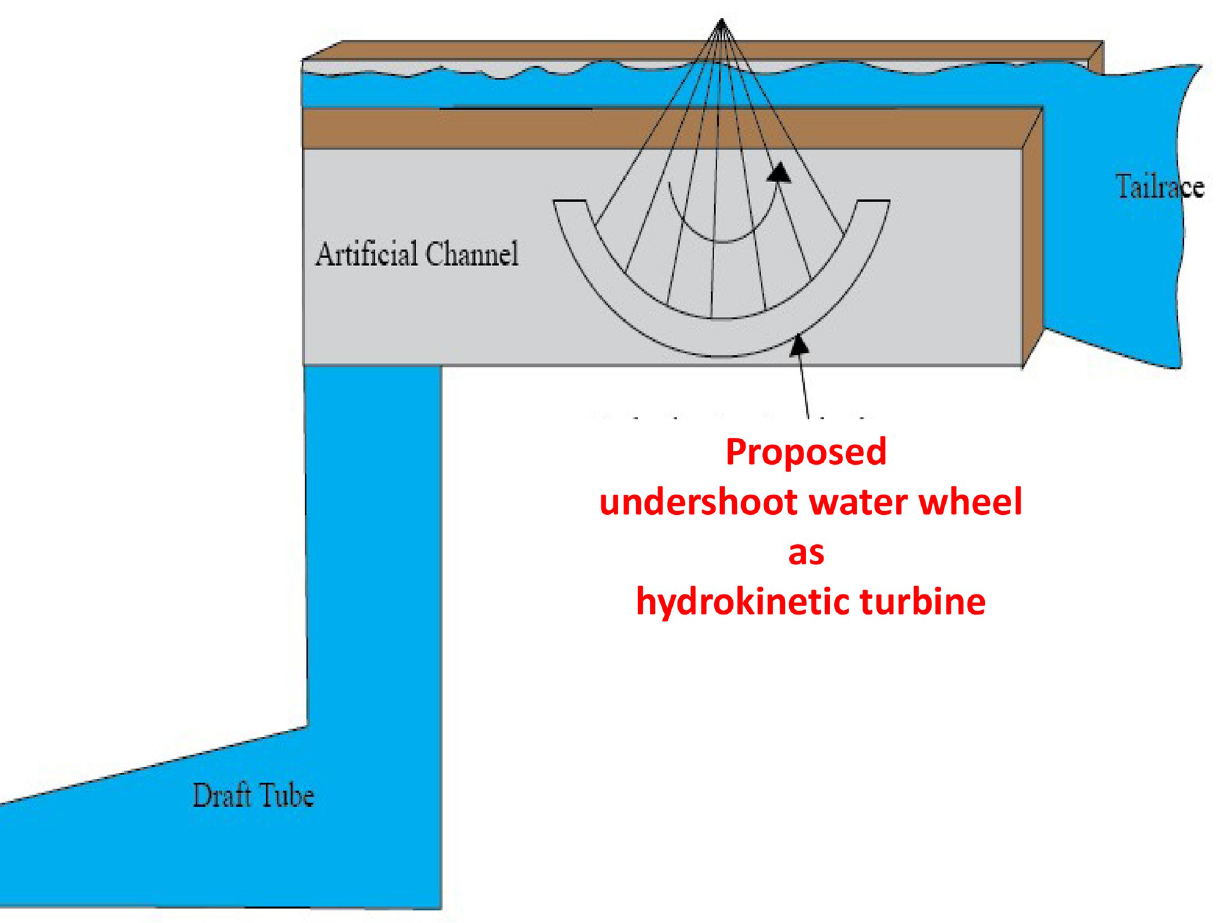
Fig 7. Proposed artificial channel construction to install hydrokinetic water